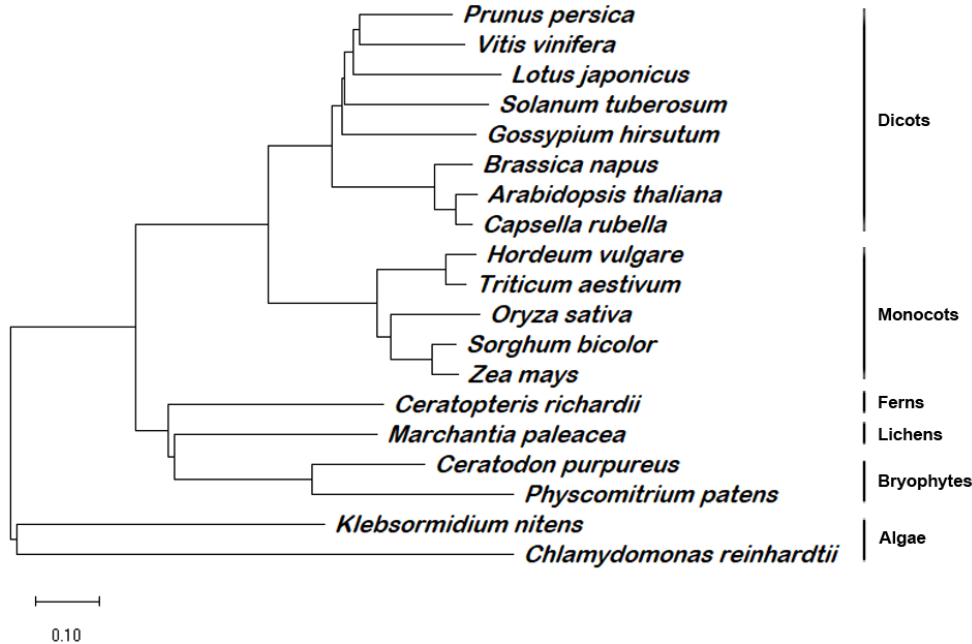
Figure 4. Phylogenetic analysis of PD1 homologous proteins. Full-length homologous amino acid sequences of PD1 protein in Arabidopsis thaliana (AT4G37920.1), Prunus persica (XP_007205240.1),